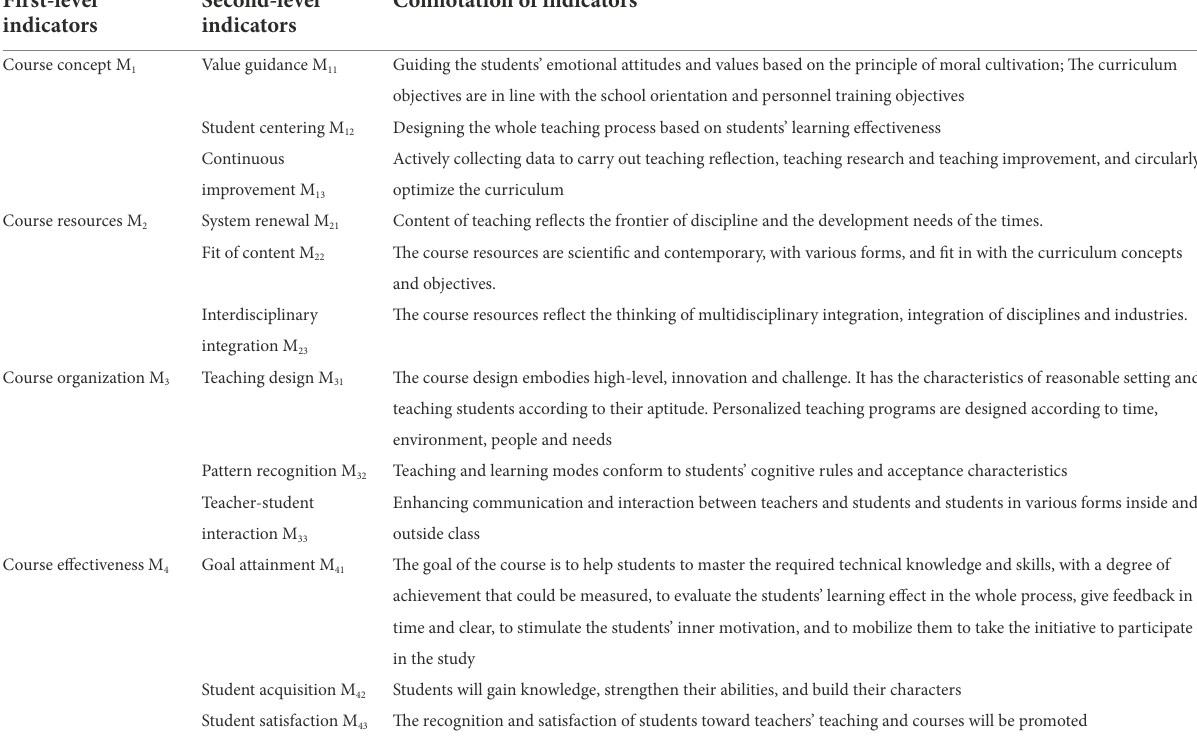
TABLE 2 Evaluation indicator system of undergraduate